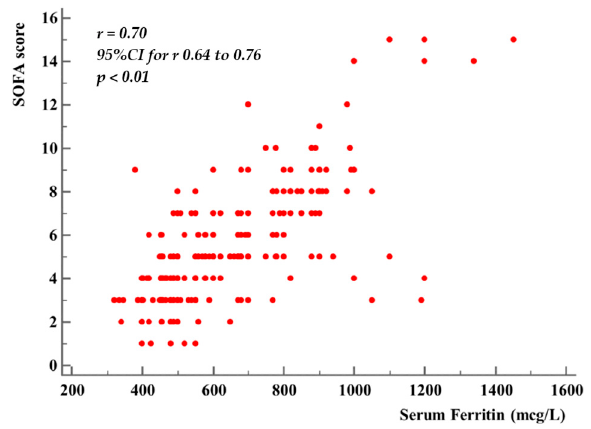
Figure 5. Relation between serum Ferritin and SOFA score.